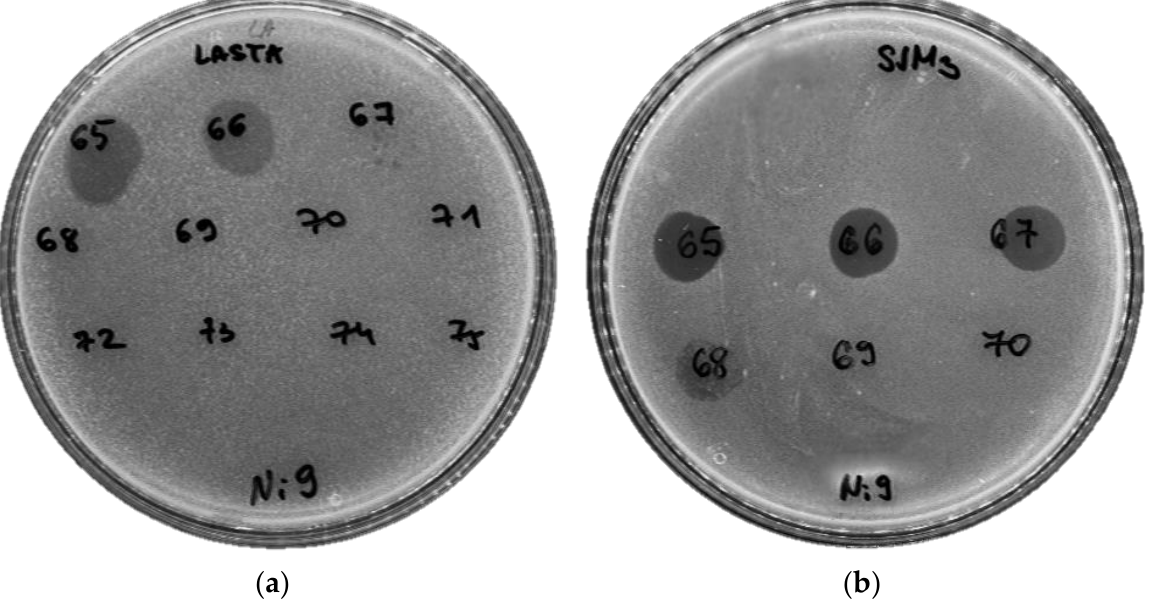
Figure 6. Temperature stability of phages. Thermal point of inactivation for ( a ) LASTA is 68 °C, and for ( b ) SJM3 it is 69 °C .